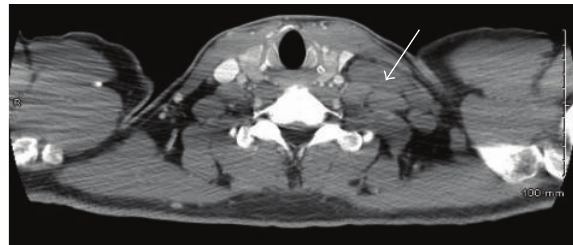
Figure 2: CT scan of the neck with left supraclavicular lym- phadenopathy